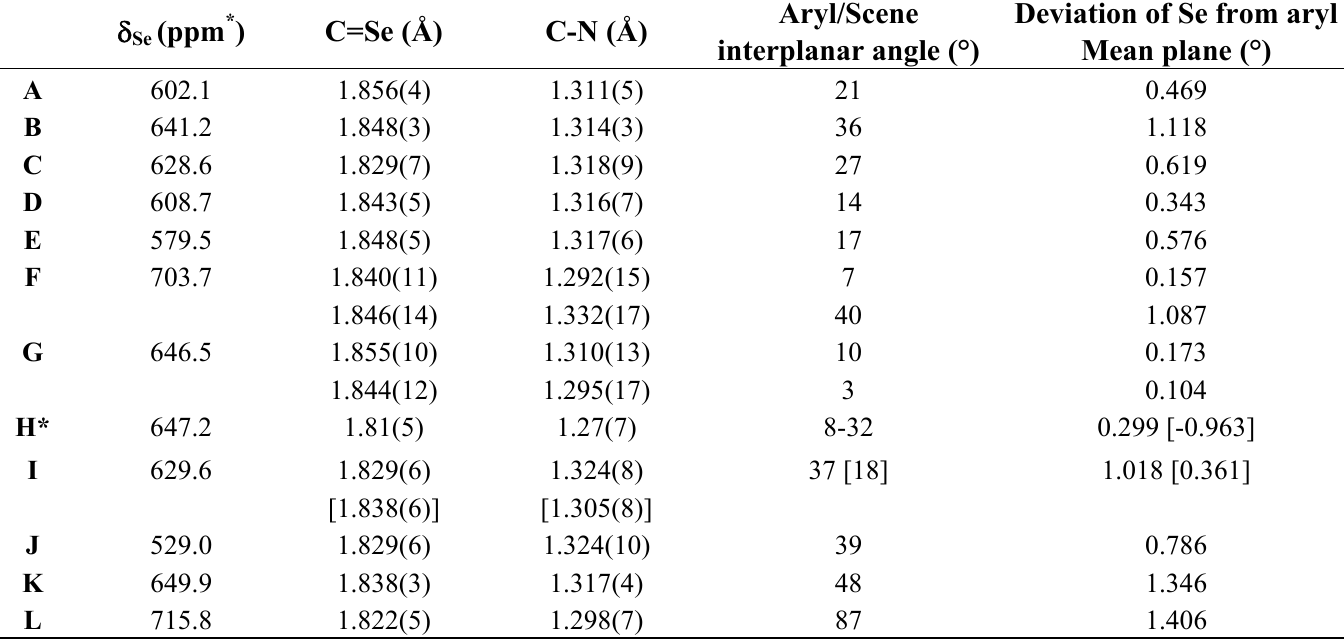
Table 1. Selected 77 Se NMR data, bond lengths (Å) and angles ( o ) (Rows containing multiple entries are a.consequence of the presence of more than one independent molecule in the asymmetric unit).